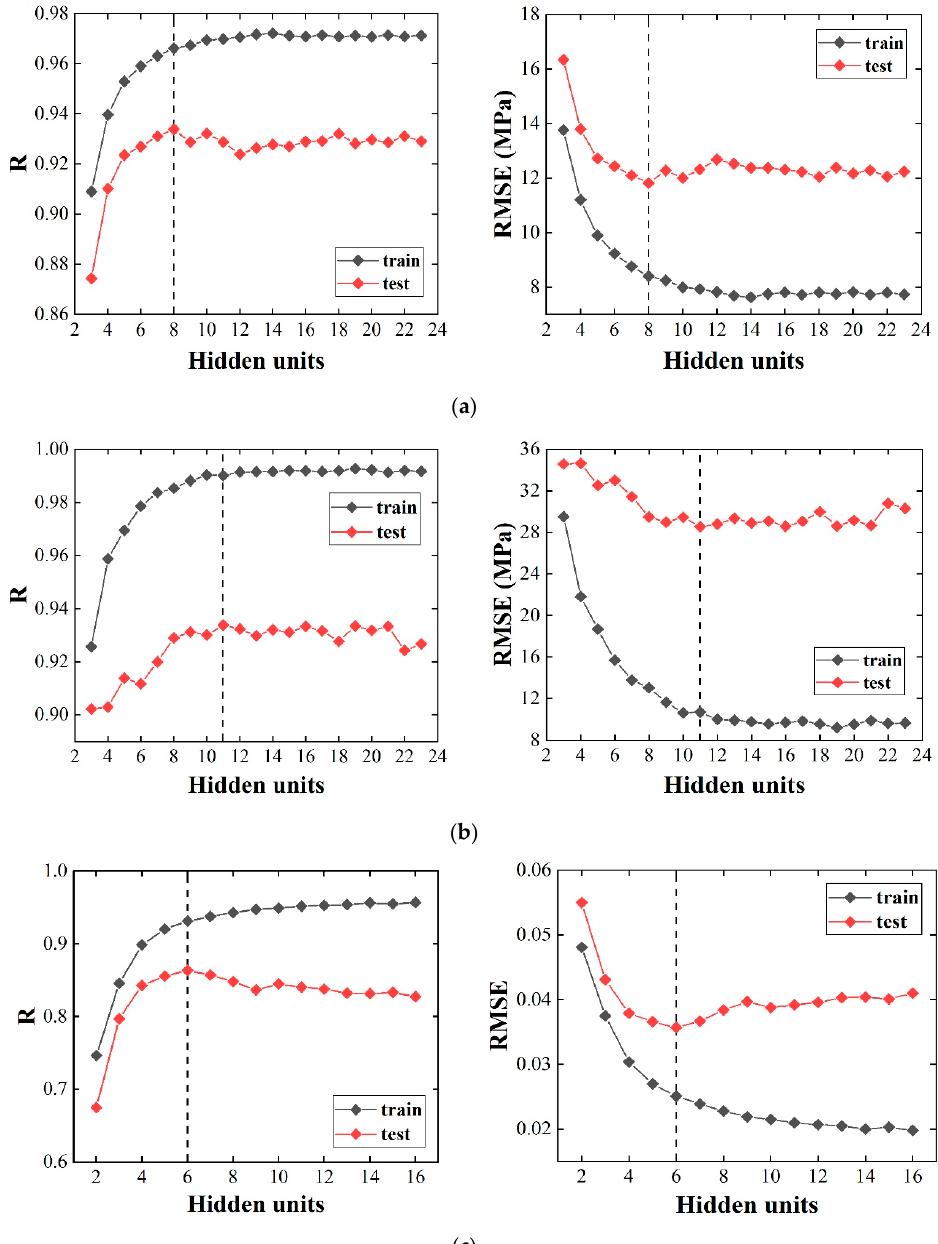
Figure 3. The number of units in the hidden layers influences the prediction of models on the training set and testing set: ( a ) yield strength (YS), ( b ) ultimate tensile strength (UTS) and ( c ) YS/UTS ratio. The black and red dots represent correlation coefficient (R) and root mean square error (RMSE) on the training set and testing set, respectively. We use the dotted lines to mark the selection of the optimal number of hidden units in every figure.